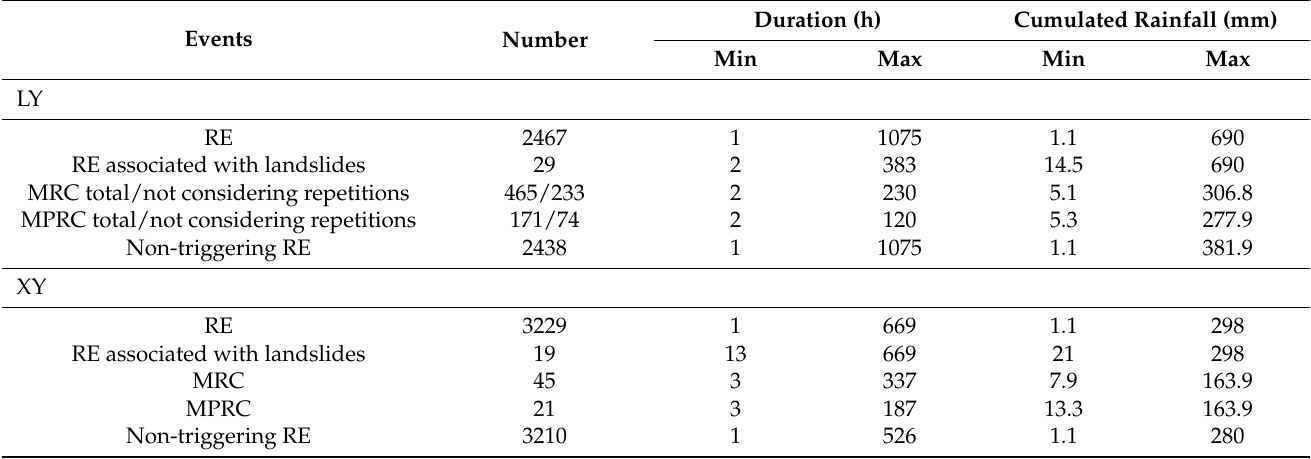
Table 3. Statistic of reconstructed rainfall events in the calibration set for Lueyang (LY) and Xunyang (XY)